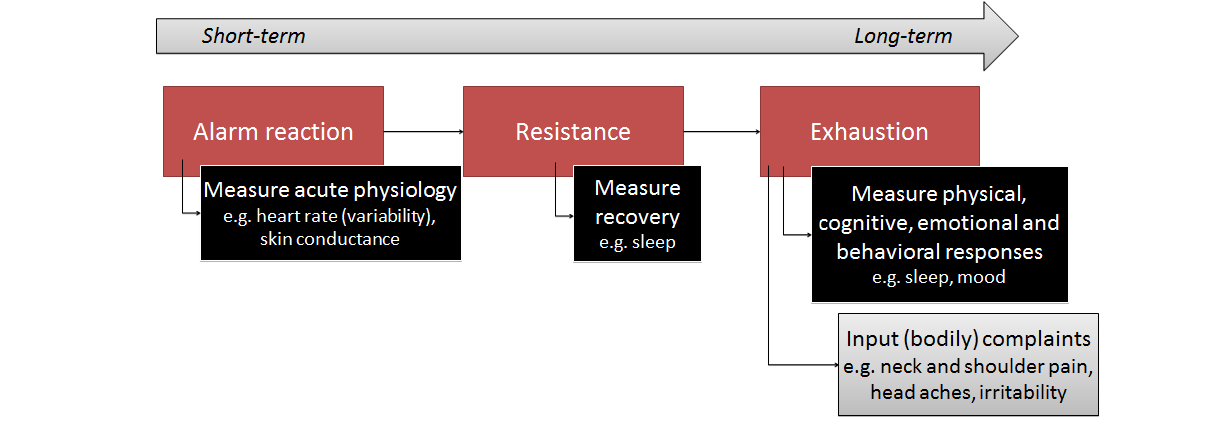
Figure 4. Stress reactions of the body and measuring possibilities.